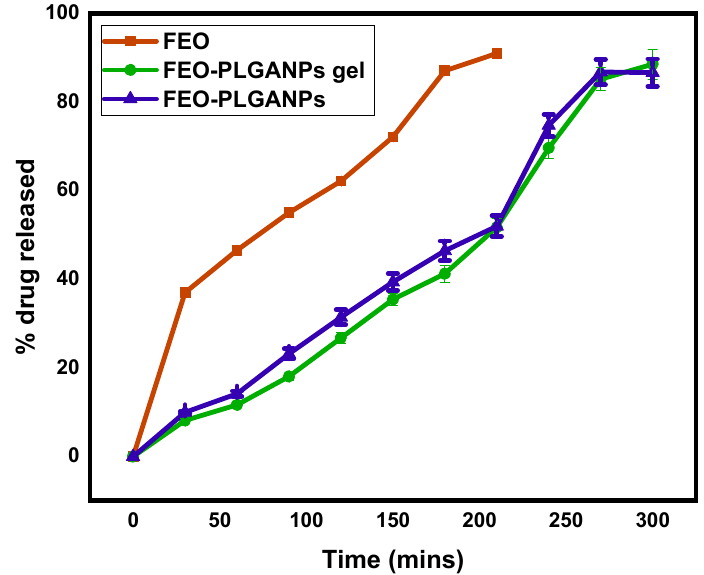
Figure 2. Comparative in vitro drug release study of FEO, FEO–PLGANPs and FEO–PLGANPs in a buffer solution of pH 6.8.